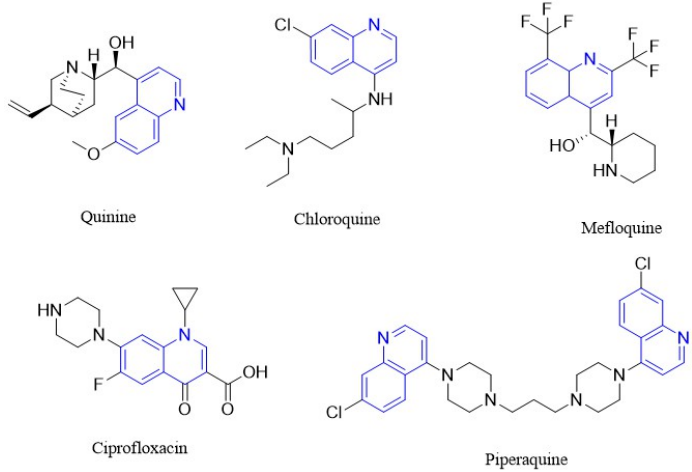
Figure 1. Selected examples of promising compounds with a quinoline ring system.